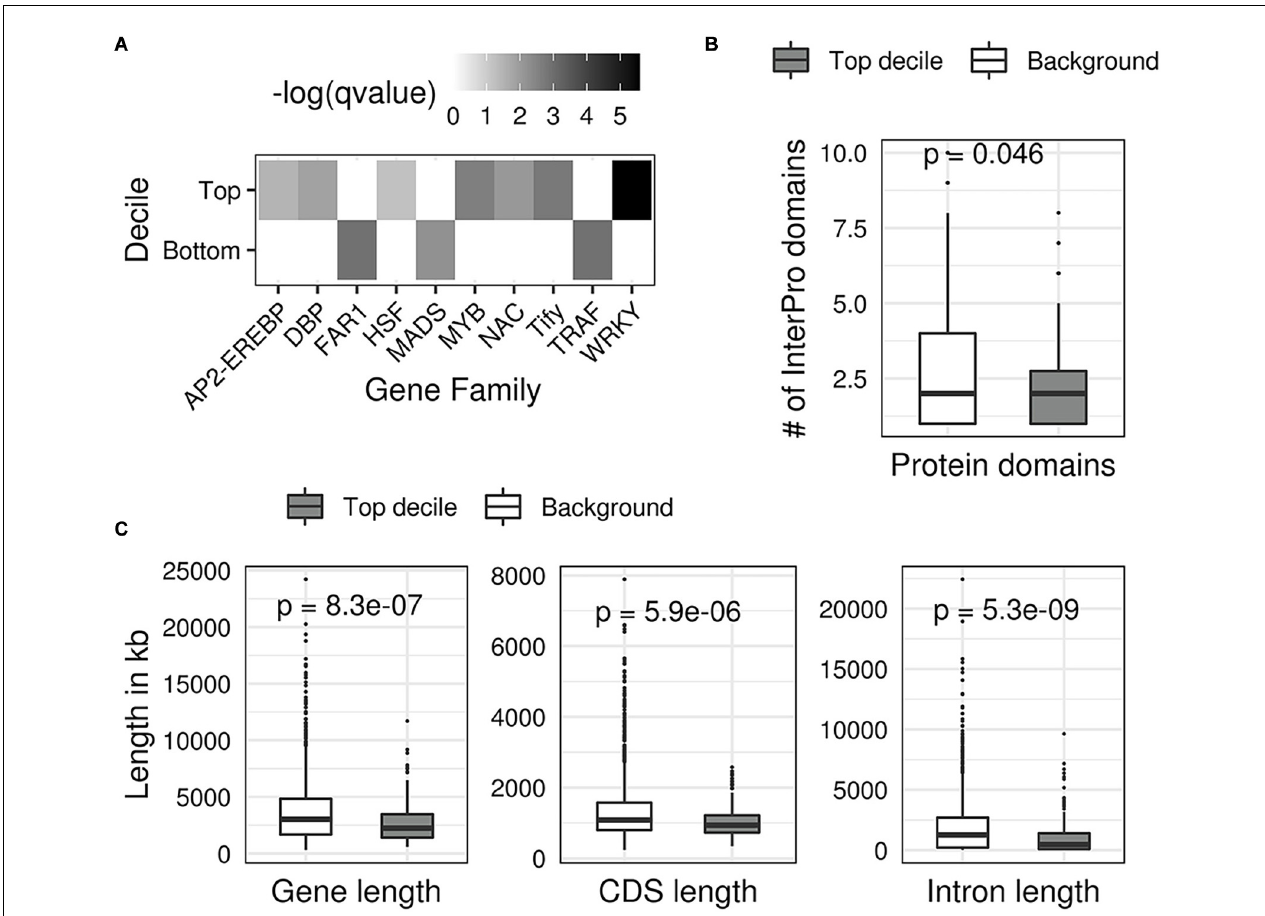
FIGURE 8 | Structural features of transcription factors with the highest drought scores. (A) A heatmap showing the enrichment of gene families in the first and last decile TFs (top 10% and bottom 10% drought scores). Each grid in the heatmap shows the FDR corrected -log ( p- value, Fisher’s exact test) of the gene family on the x-axis for the decile on the y axis. (B) Boxplots showing that top decile TFs contain a significantly different number of protein domains compared to the background of TFs in the remaining deciles. (C) Boxplots showing that the top decile TFs have significantly smaller average gene length, coding sequence length (CDS), and intron length compared with the background of remaining